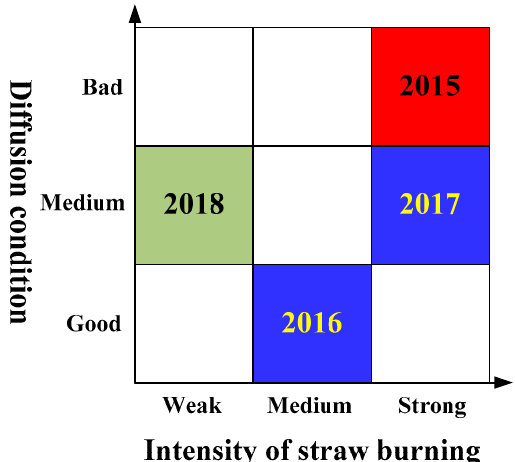
Figure 4. Qualitative relationships between the AQI, the intensity of the source of straw burning, and the meteorological conditions in October and November 2018. Note: The intensity of the emission source is mainly divided into three levels according to the number of fire points; meteorological diffusion conditions are mainly divided into three levels based on wind speed, humidity, and precipitation data.